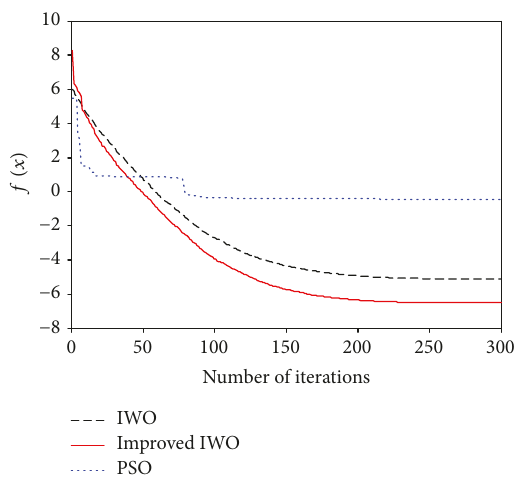
Figure 9: Diagram of iterative curves.